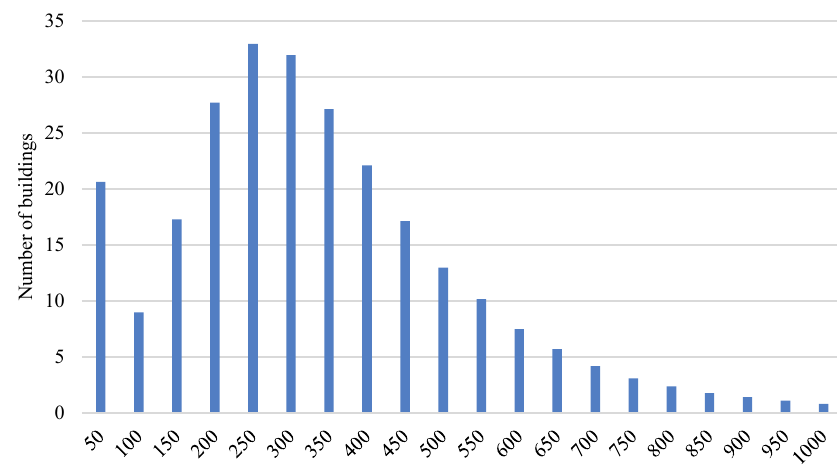
Fig. 3. Number of homes and the total monthly electrical energy